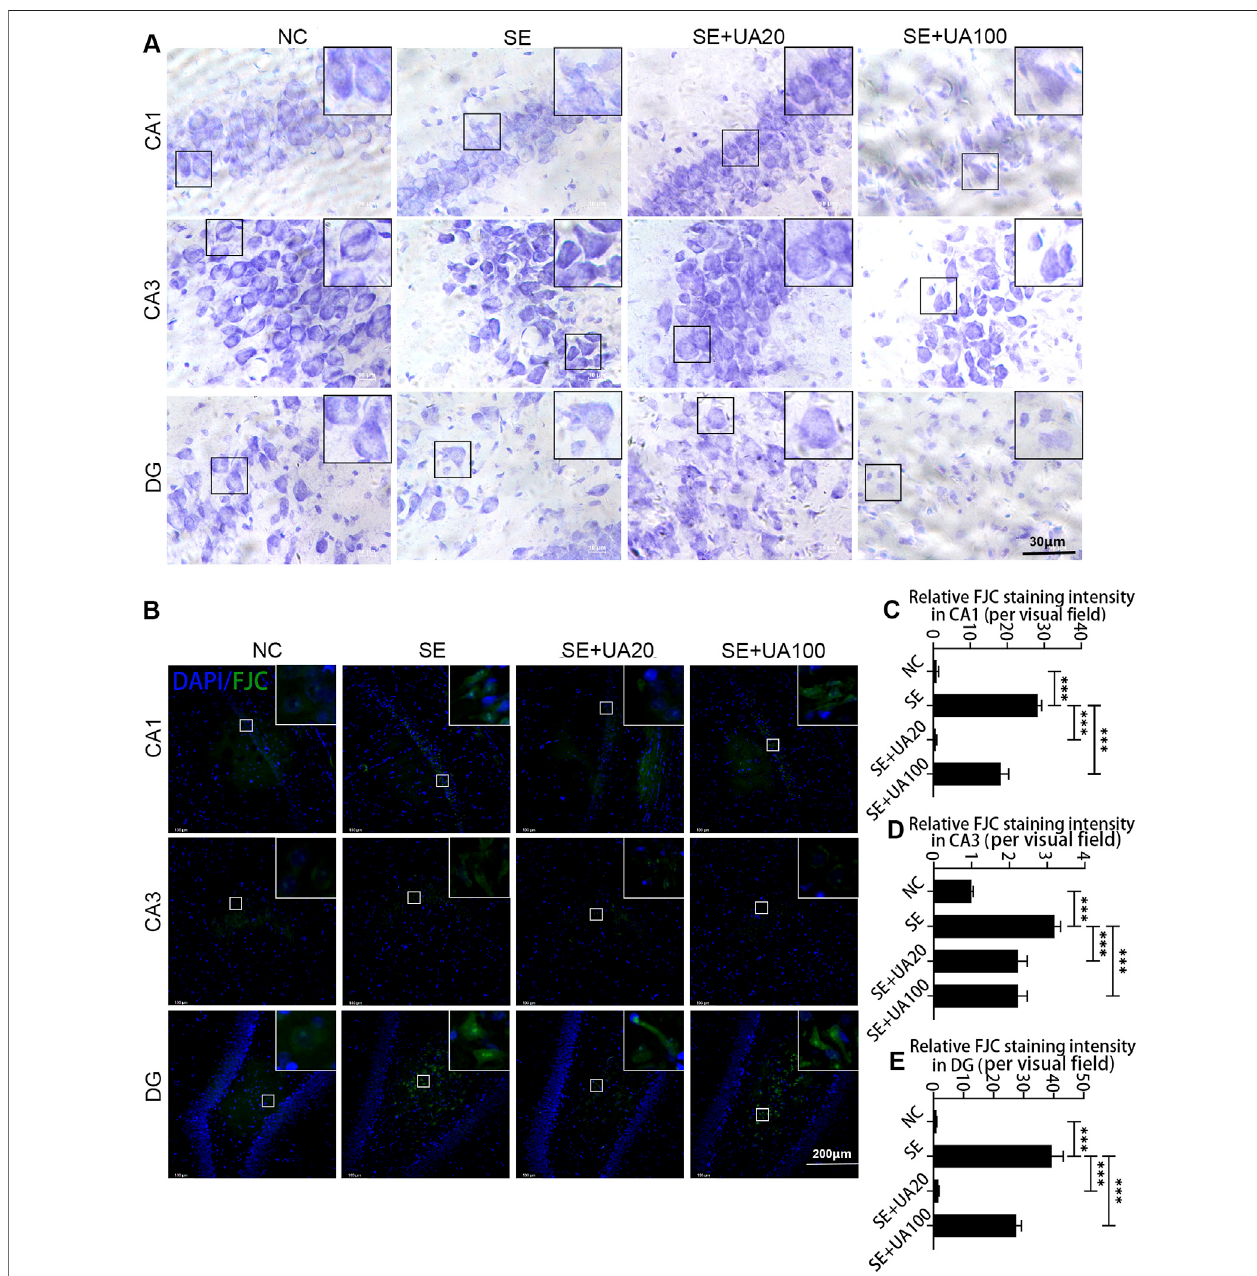
FIGURE 4 | The neuroprotective effect of UA during SE. Nissl (A) and FJC (B) staining were used to detect the damage and repair of hippocampal neurons in the CA1, CA3,and DG regions ofeach groupofrats. Relative stainingintensitiesofFJCin CA1 (C) ,CA3 (D), and DG (E) werecompared(three rats per group, allvalues are expressed as means ±SD, ppp p < 0.001 vs . SE, one-way